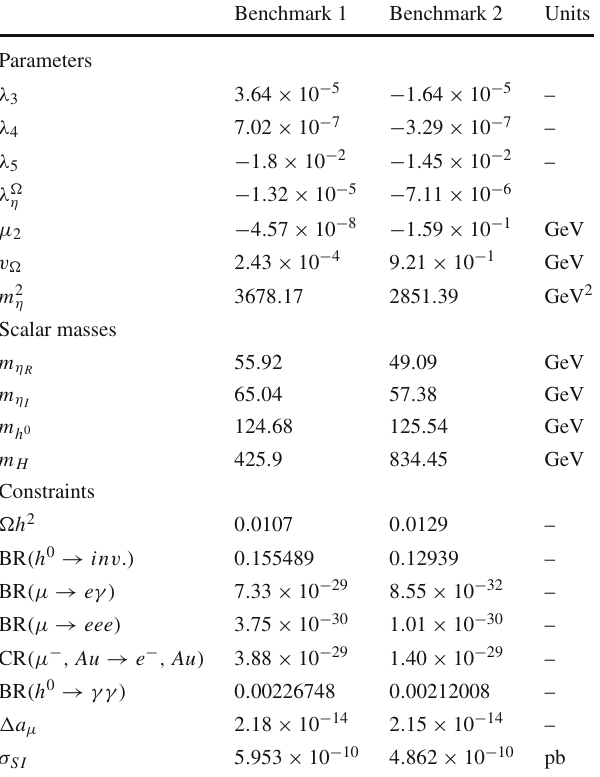
Table 3 Benchmark points which survive the entire set of constraints described in Sect. 3.2 and corresponding parameters relevant to the calculation of diagrams in (cid:2) E T + jet final states